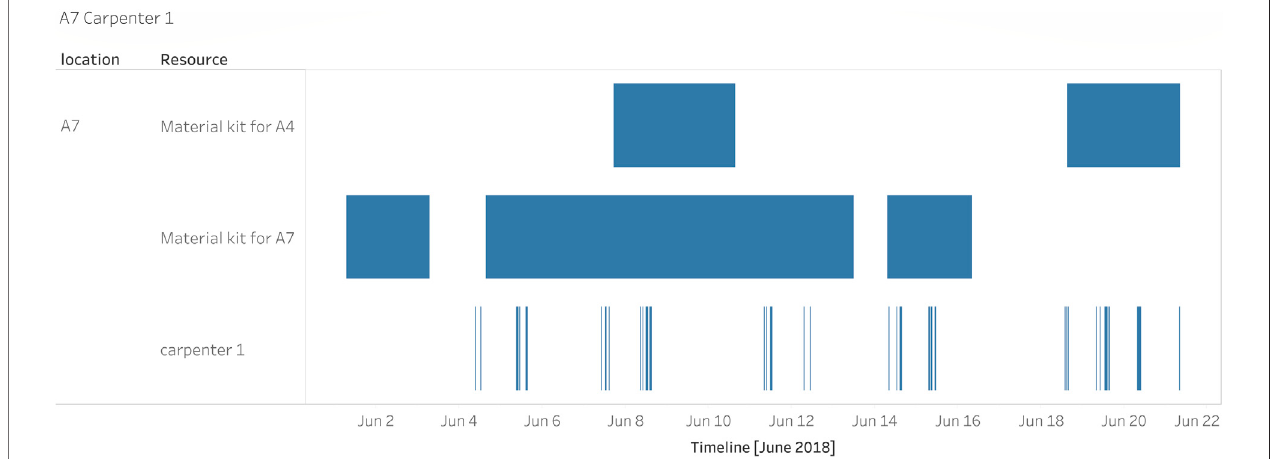
FIGURE 8 | Movement visualization of carpenter 1 with material kits in apartment A7.